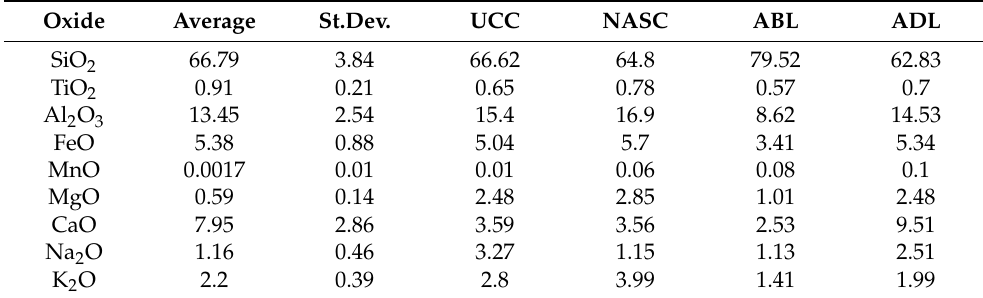
Table 1. The experimental average values ± one standard deviation (St.Dev.) of major elements’ (as oxides) mass fractions, together with corresponding values of UCC [22], NASC [23], ABL [24], and ADL [25]. All mass fractions are expressed in wt%.